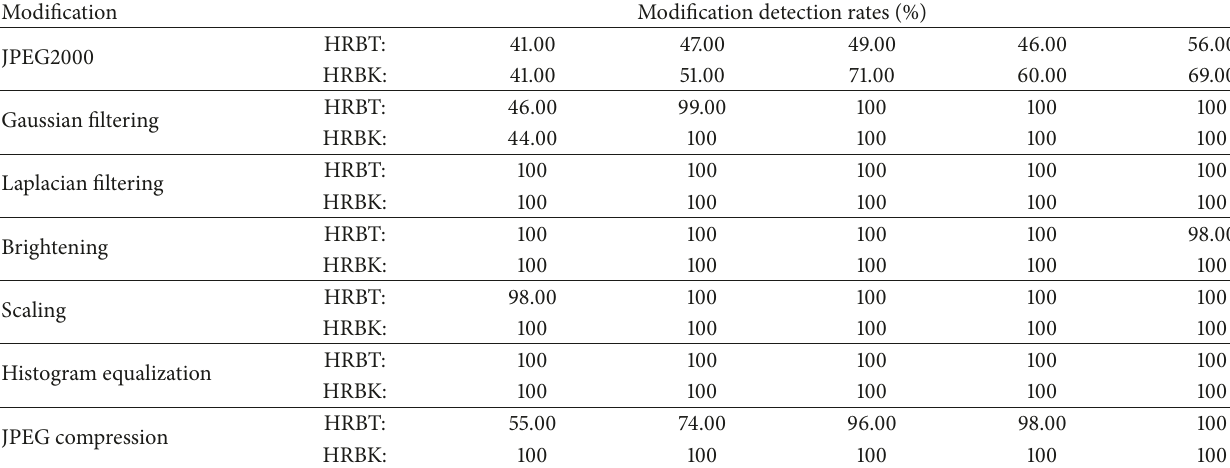
Table 4: Detection rates (%) with HRBT and HRBK features for different modification parameterizations (CT image dataset).